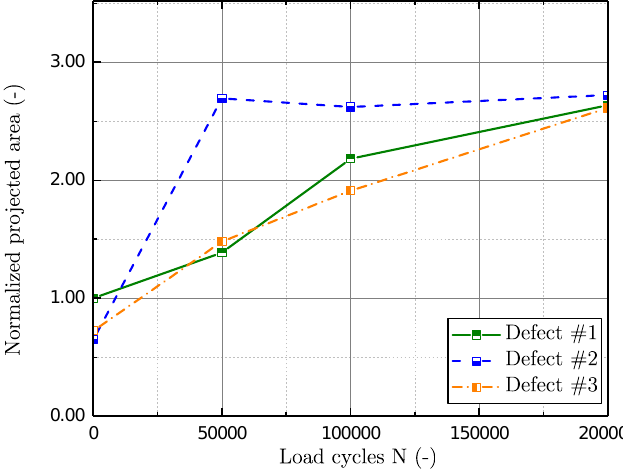
Figure 17. Projected area of representative defects over load-cycles.